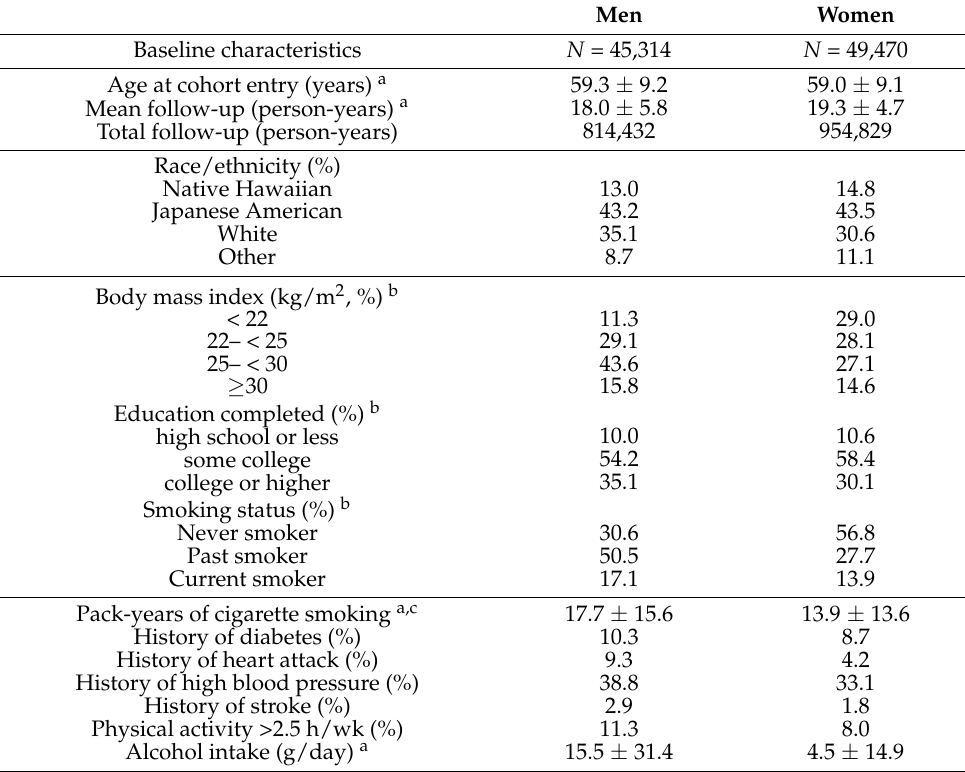
Table 1. Study sample characteristics, Multiethnic Cohort (Hawaii